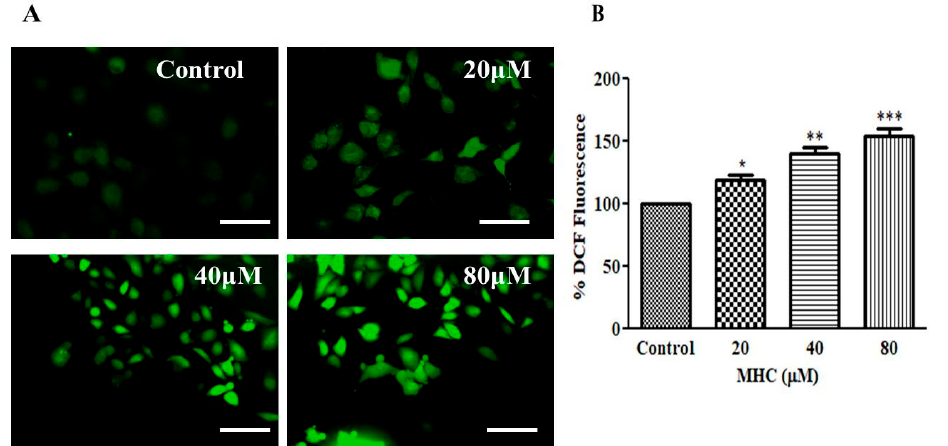
Figure 7. MHC-mediated instigation of intracellular ROS as assessed through ( A ) DCF-DA stained fluorescent photomicrographs and ( B ) quantification of DCF-DA-mediated mean fluorescence intensity within MCF-7 cells. * p < 0.05, ** p < 0.01 and *** p < 0.001.